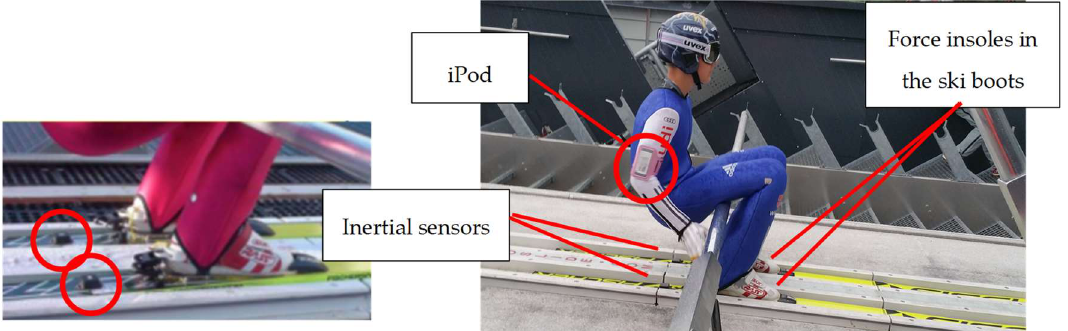
Figure 1. Placement of the iPod case, force insoles and inertial sensors on a